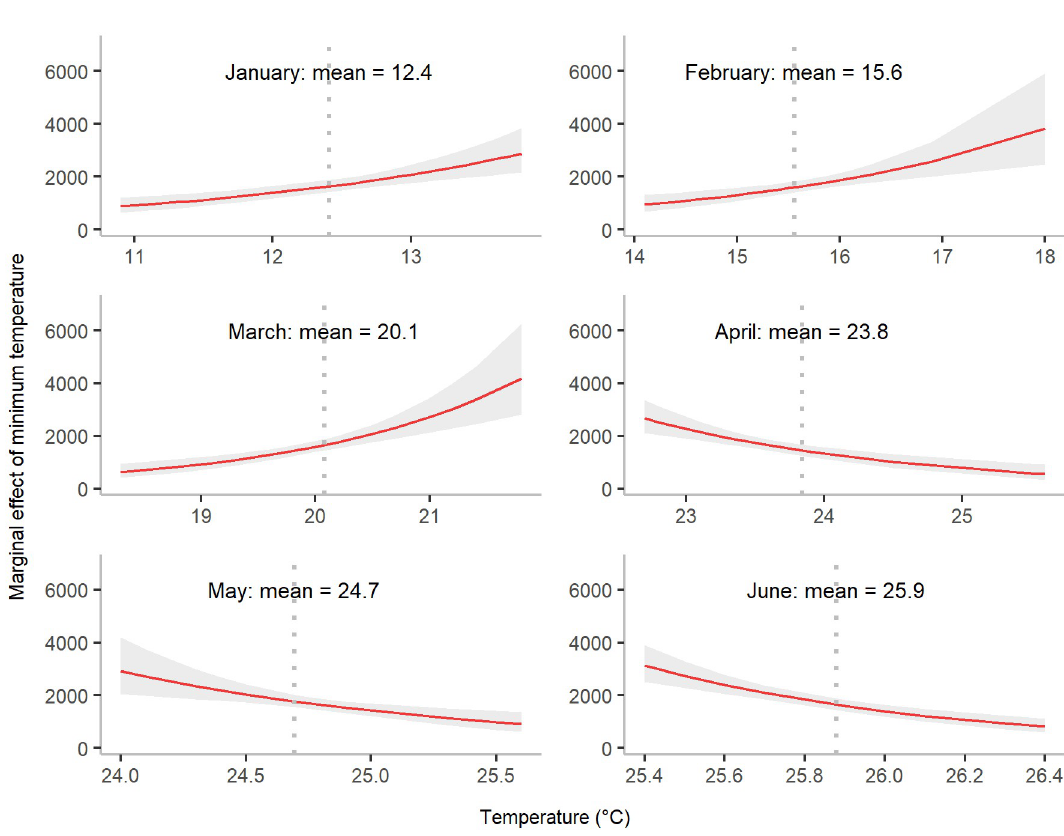
Fig 6. Marginal effect of minimum temperature from January to June on annual dengue cases. The shaded area denotes the 95% confidence interval of annual dengue cases at different values of minimum temperature, whereas the dotted vertical line represents mean minimum temperature for a month. The marginal effect here represents marginal effects at the mean (MEMs).